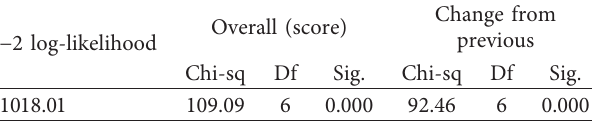
Table 9: Omnibus test of model coefficients.